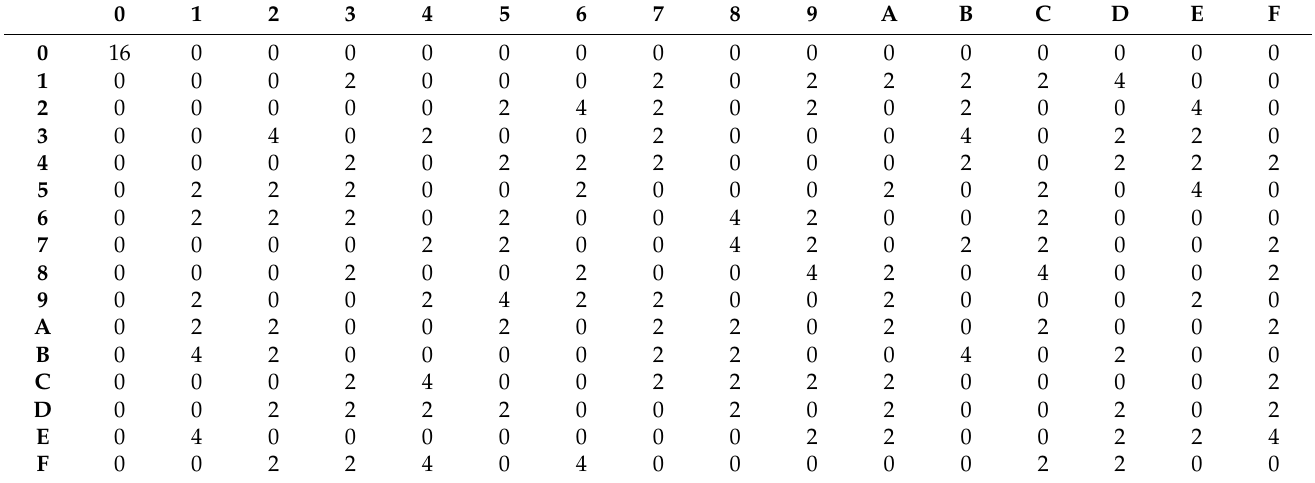
Table 4. S 2 box